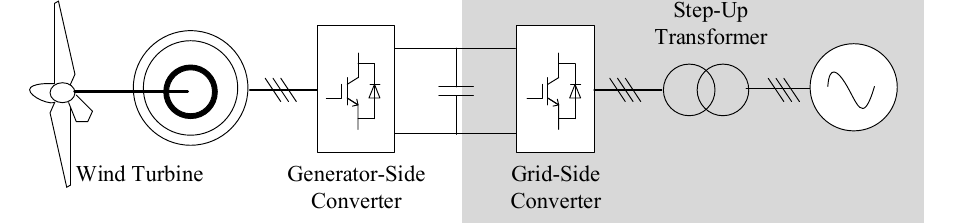
Figure 1. Structure schematic diagram of Type-IV wind generator.